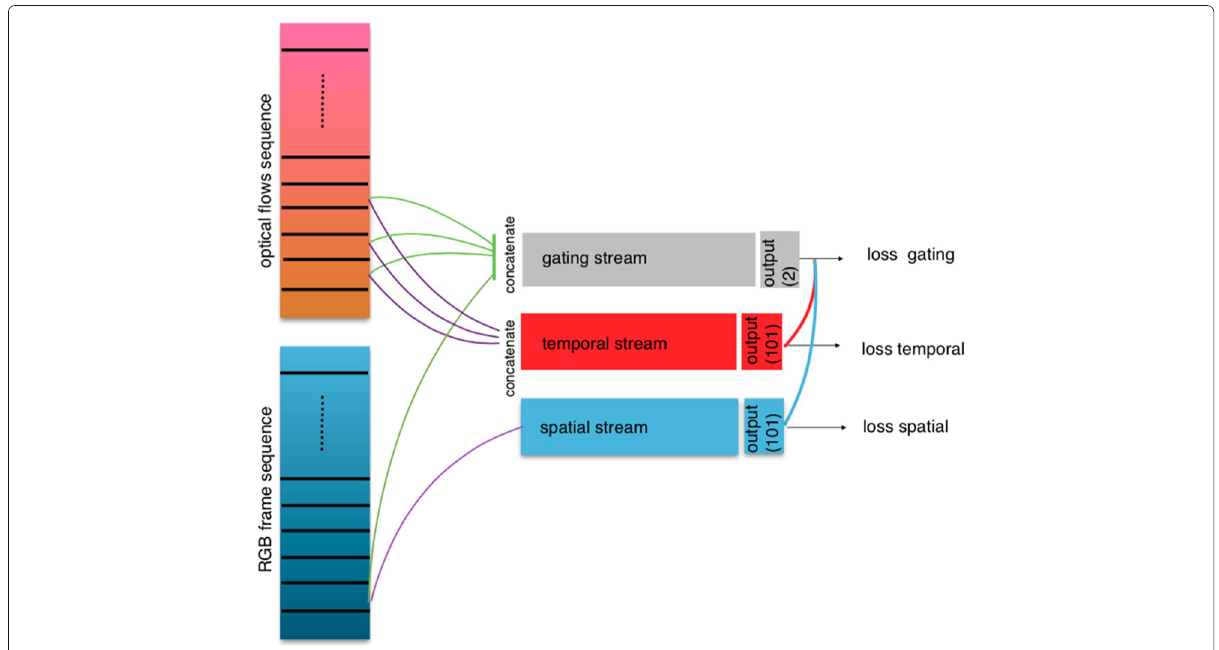
Fig. 2 Expert–gating training framework [25,